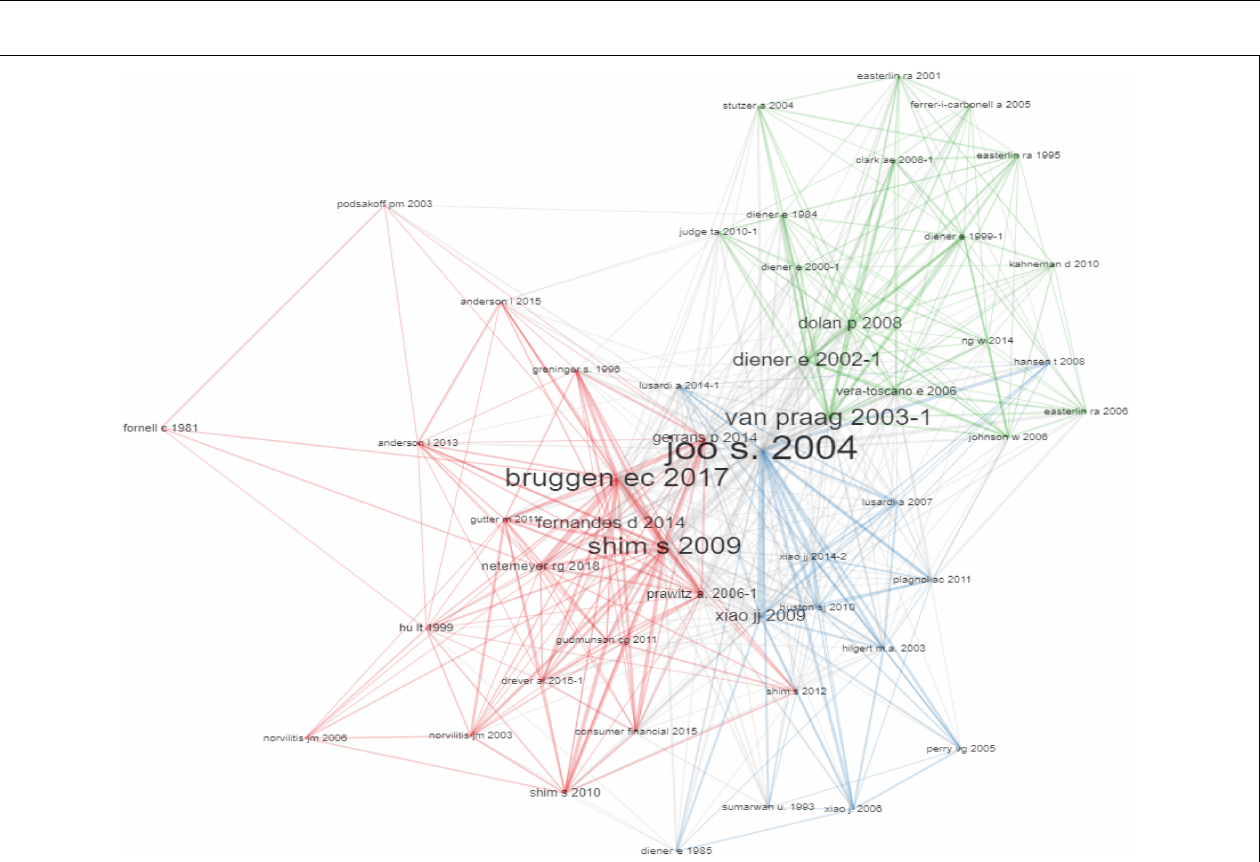
FIGURE 4 | Three-field plot of relations between author keywords, authors, and source.